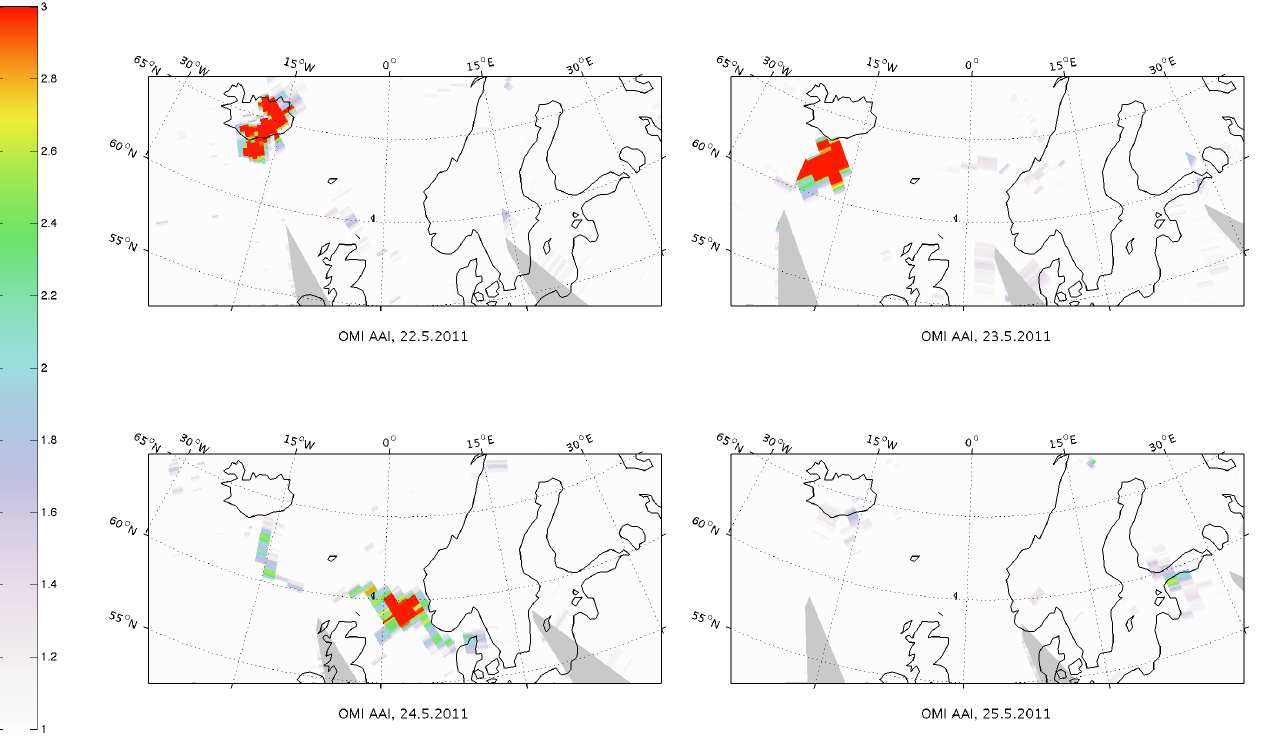
Fig. 2. The AAI index measured by OMI during the afternoon on 22, 23, 24 and 25 May 2011.